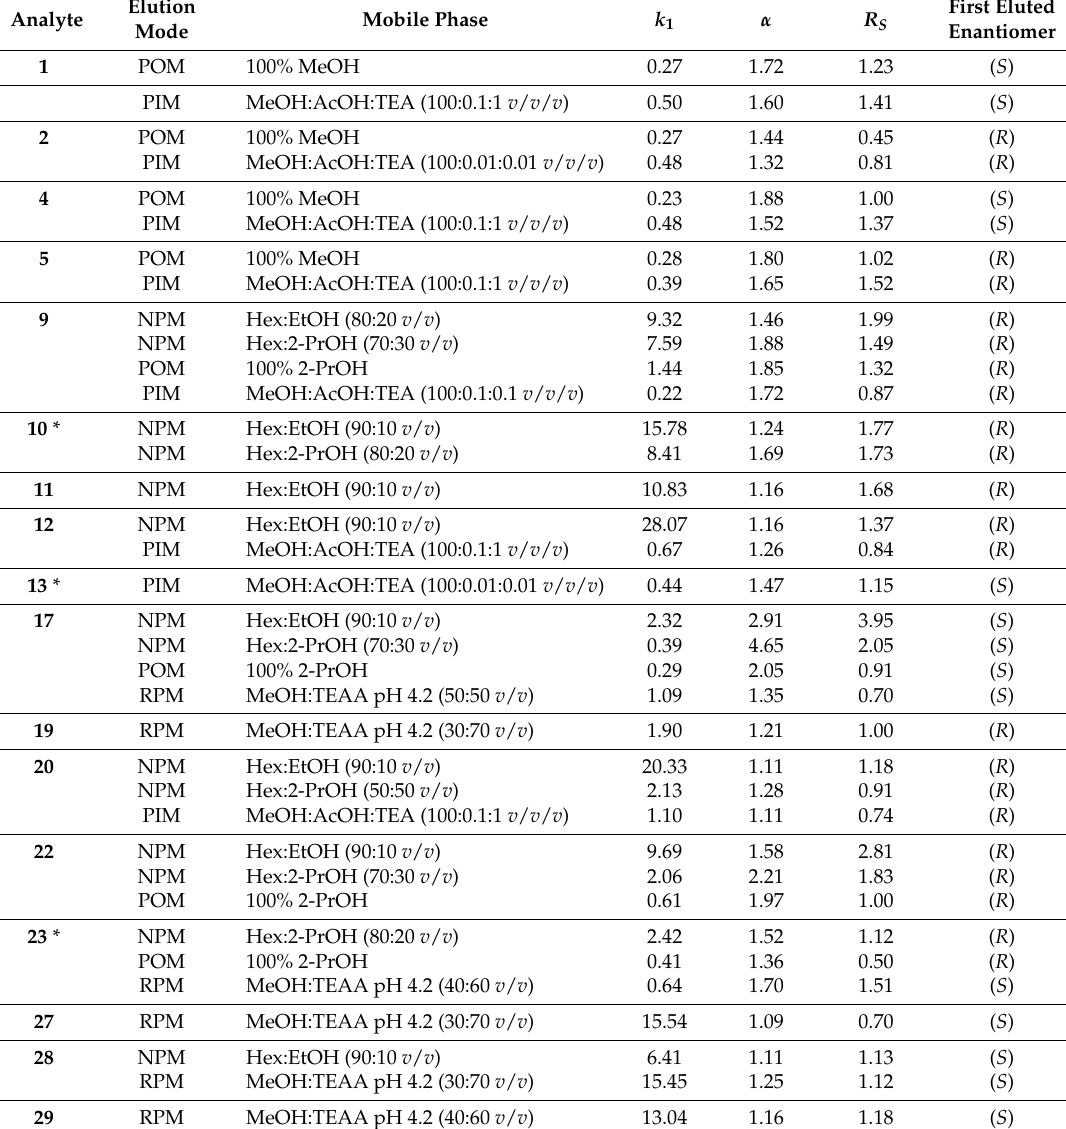
Table 2. Chromatographic data, retention factor of first eluted enantiomer ( k 1 ), separation factor ( α ), resolution ( R S ), and elution order, for the chiral xanthonic analytes on Chirobiotic TM R column, under multimodal chromatographic